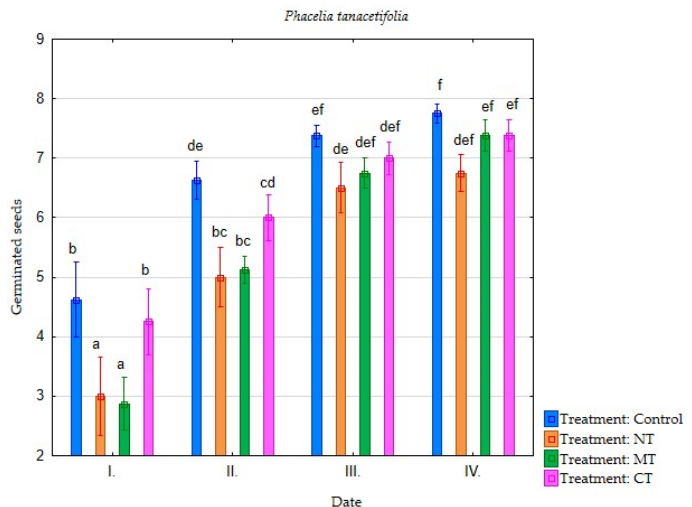
Figure 4. Development of the germination of Phacelia tanacetifolia caryopses watered with soil leachates from different soil tillage. The results represent the mean of 8 biological replicates ± SE. Identical letters express statistical non-significance between the variants, different letters express statistical significance at a significance level p = 0.05 (Fisher LSD test). The plot shows the mean, the whiskers representing the standard error, values with different letter (a, b, c, d, e, f) differ significantly. Variants of tillage technologies: CT—Conventional tillage with ploughing; MT—Minimum tillagethe; NT—Direct